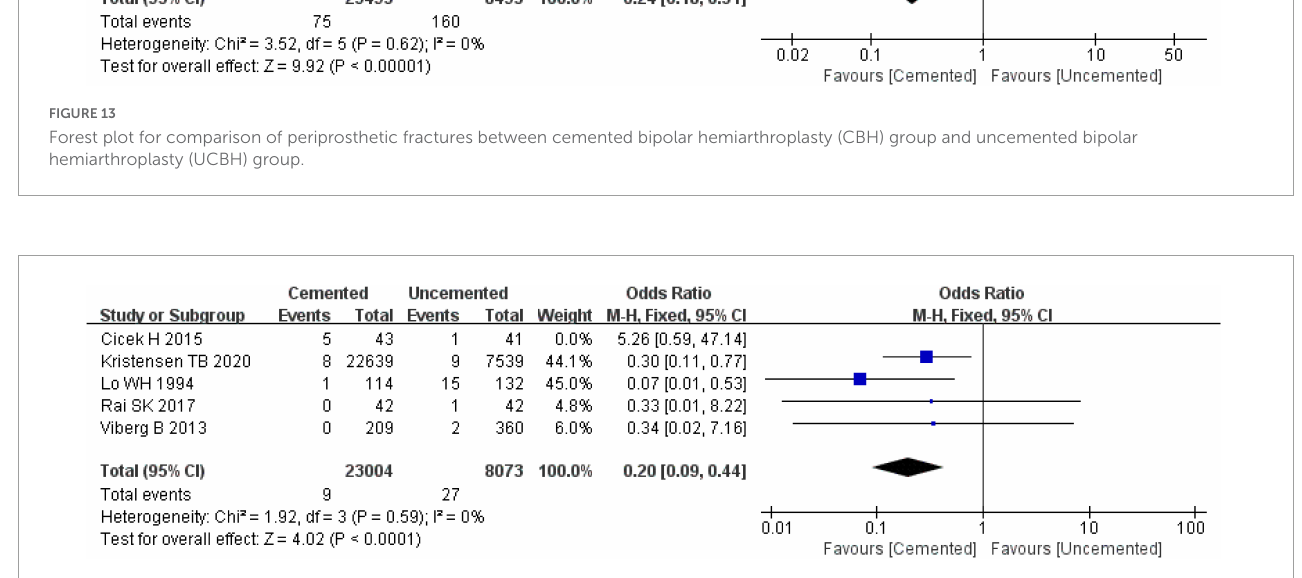
FIGURE14 Forest plot for comparison of aseptic loosening of prosthesis between cemented bipolar hemiarthroplasty (CBH) group and uncemented bipolar hemiarthroplasty (UCBH) group.